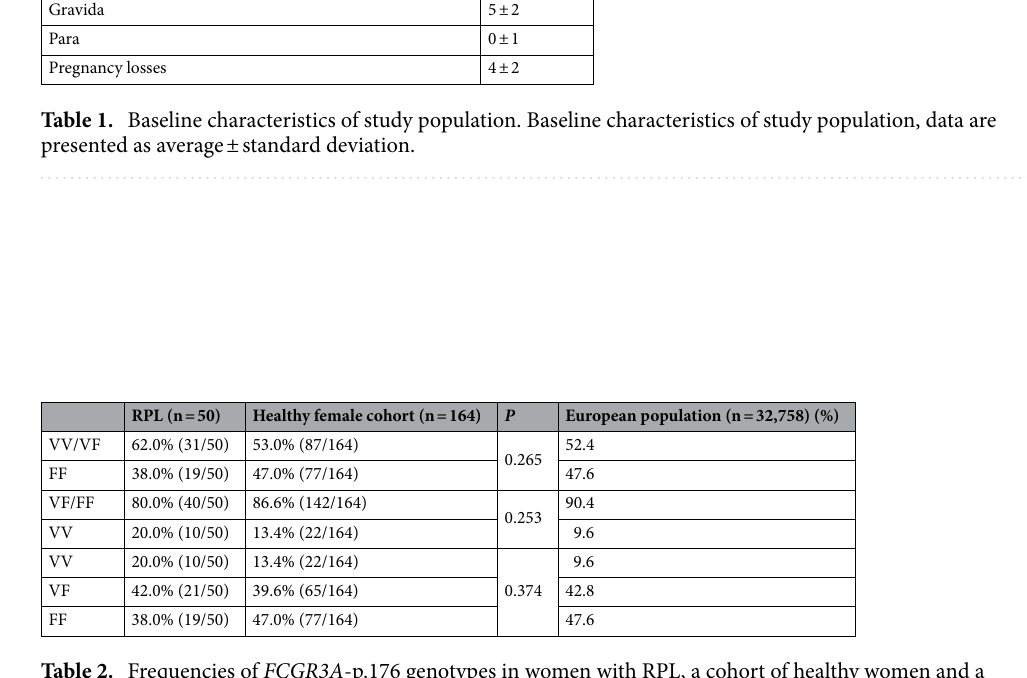
Table 2. Frequencies of FCGR3A -p.176 genotypes in women with RPL, a cohort of healthy women and a European cohort. Frequencies of FCGR3A -p.176 genotypes were based on the valine and phenylalanine SNP on amino acid position 176 for RPL women, healthy women and calculated from ALFA Allele Frequency (dbSNP) for a European population.